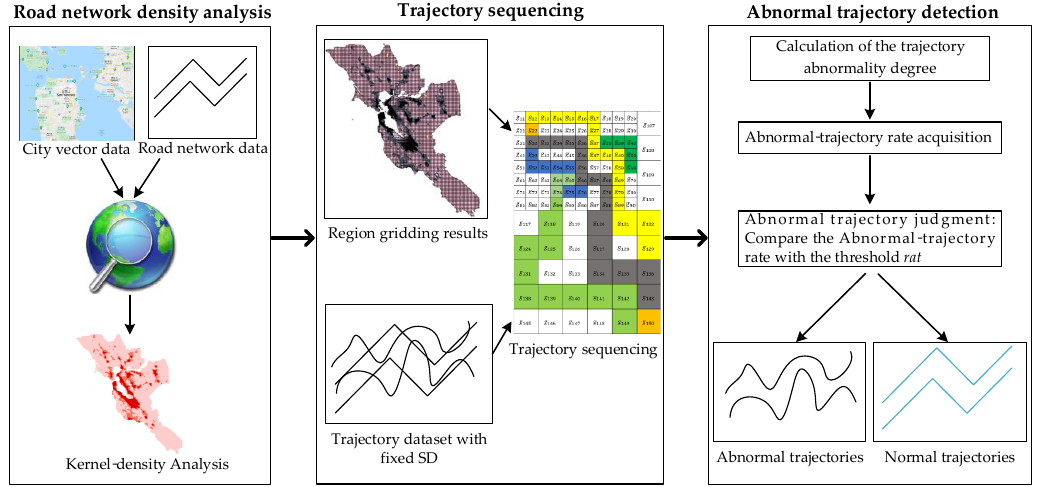
Figure 2. Abnormality-detection framework.